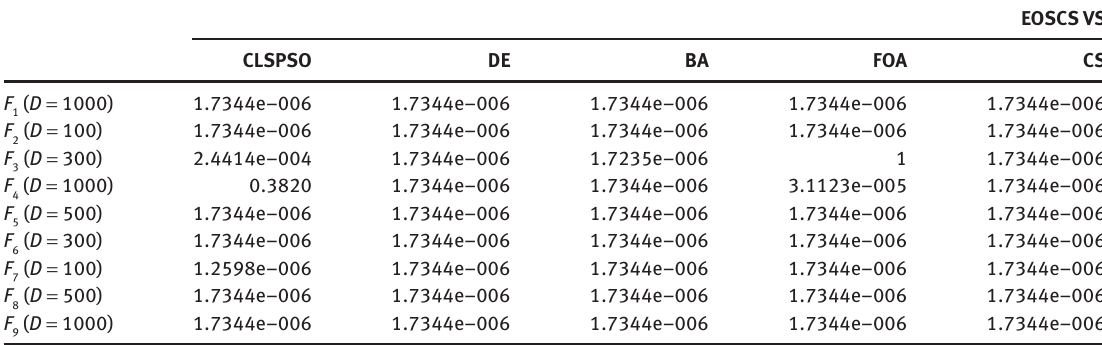
Table 11: p -Values Produced by Wilcoxon’s Test Comparing EOSCS versus CLSPSO, EOSCS versus DE, EOSCS versus BA, EOSCS versus FOA, and EOSCS versus CS Over The “Average Best-So-Far” Values from Table 4 (high dimensional).